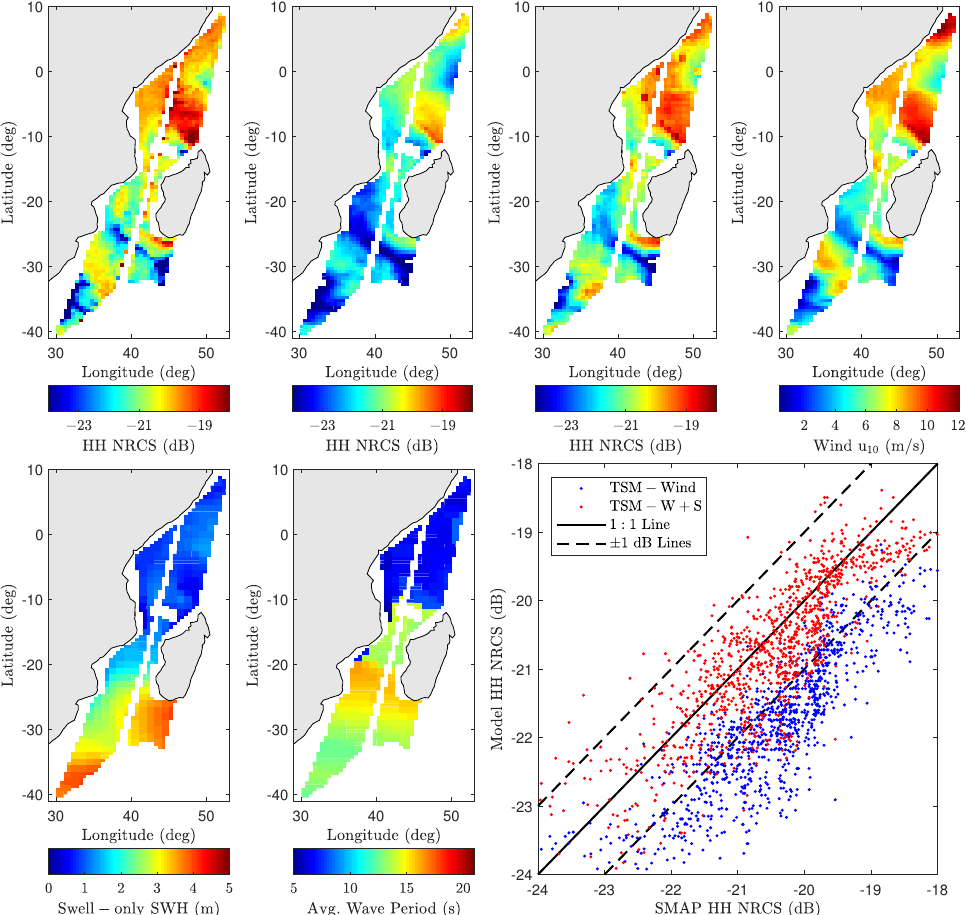
Figure 16. SMAP vs. model backscatter NRCS comparison for pass 02260_D on 5 July 2015, at 02:32:47 UTC near Madagascar at glo_30m resolution. ( Top row ) from ( left ) to ( right ): backscatter NRCS for SMAP, wind-only model, wind and swell model, and wind speed. ( Bottom row ) from ( left ) to ( right ): swell-only SWH, average wave period, measured vs. modeled scatter